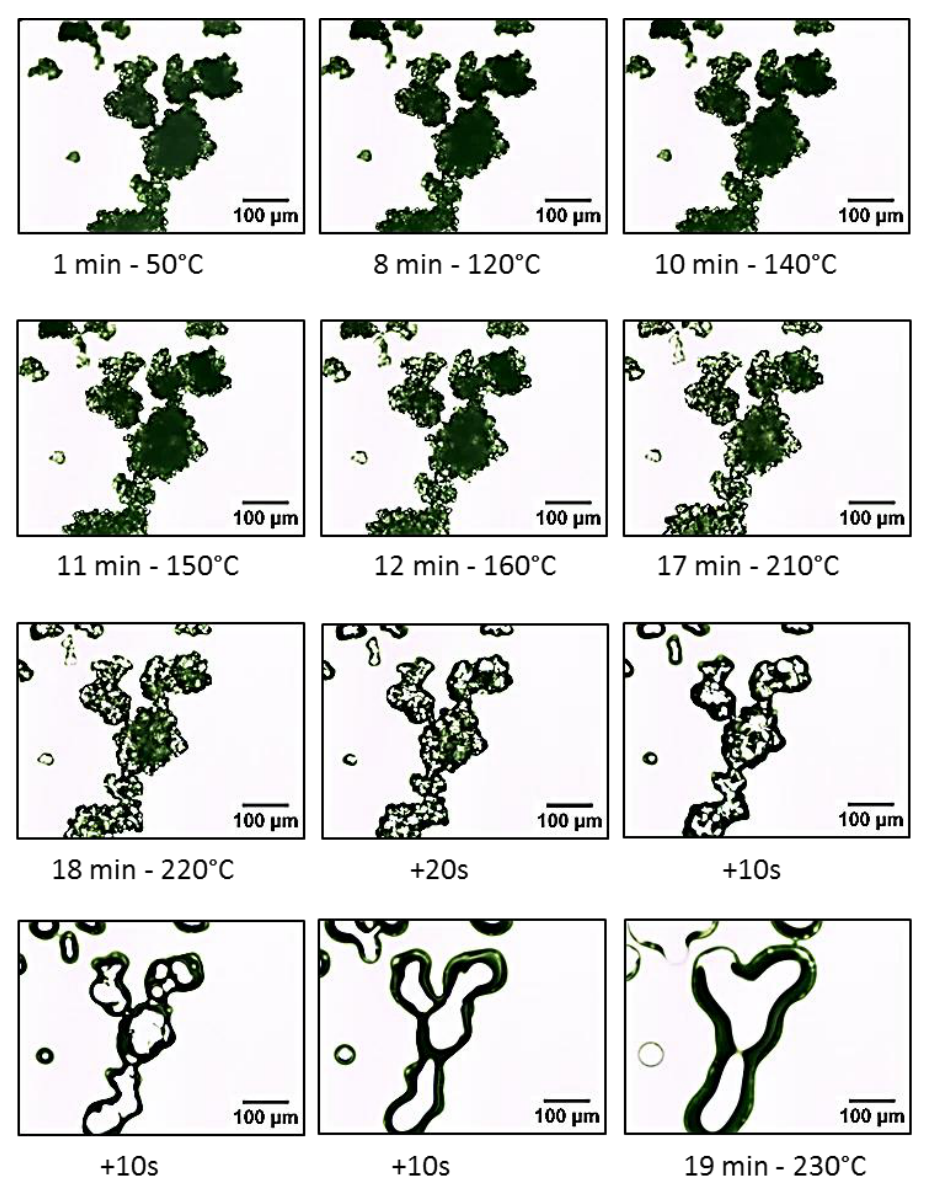
Figure 12. Hot stage microscopy images of UHMWPE.